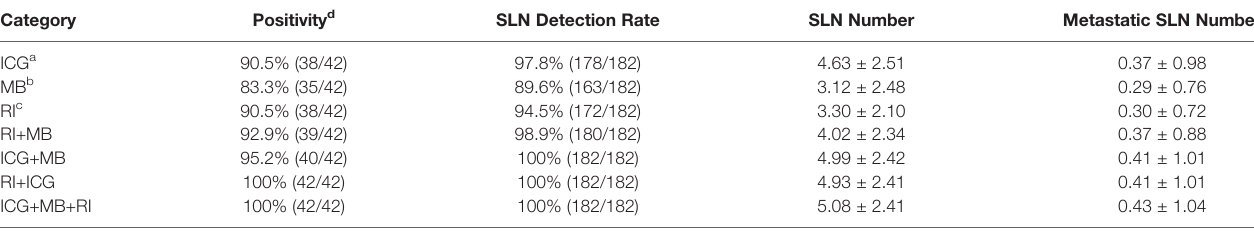
TABLE 2 | Axillary sentinel lymph node tracer status.